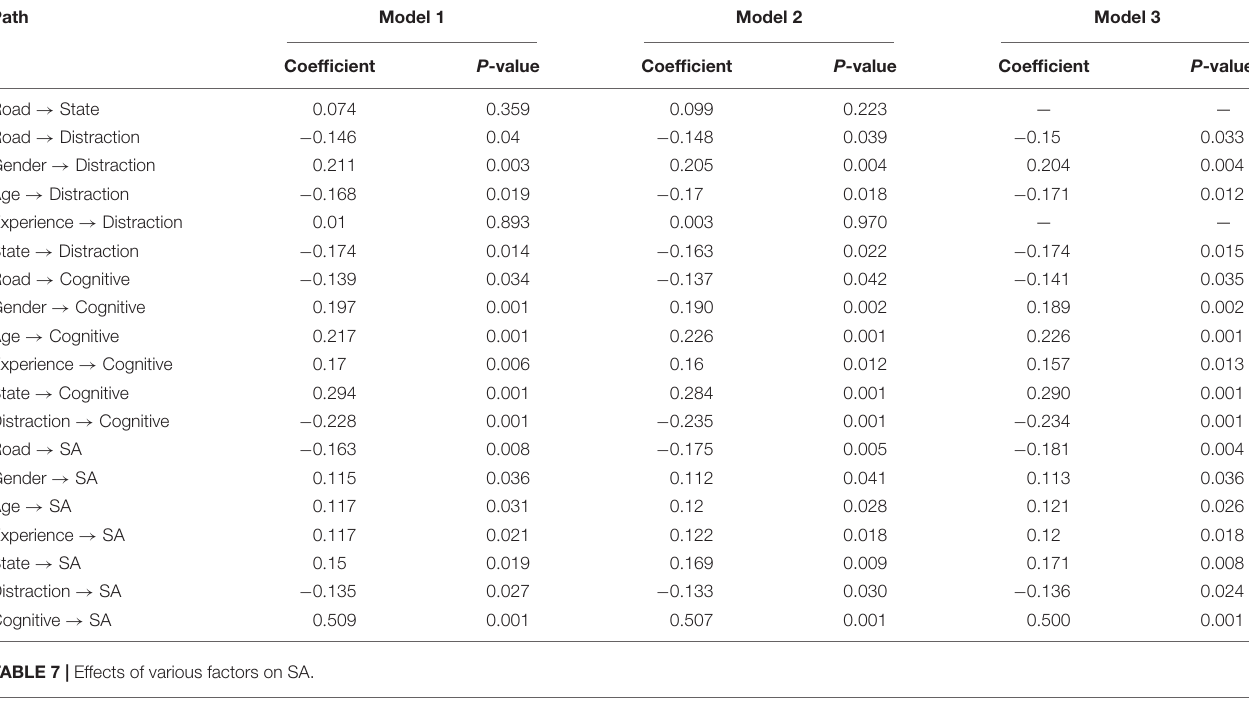
TABLE 6 | Estimation results.